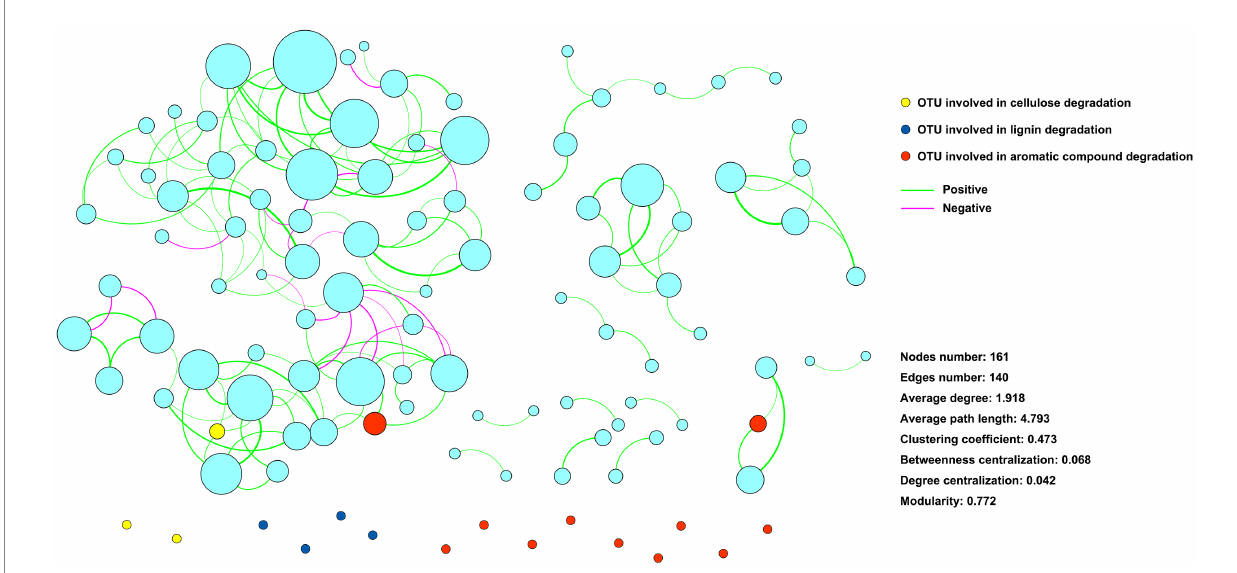
FIGURE 5 Ecological network showing the associations among community components. Nodes represent zOTUs, and the size of the node indicates the relative abundance of the zOTU. Nodes colored with yellow, blue, and red indicate zOTUs involved in cellulose, lignin, and aromatic compound degradation, respectively. Edges indicate associates between